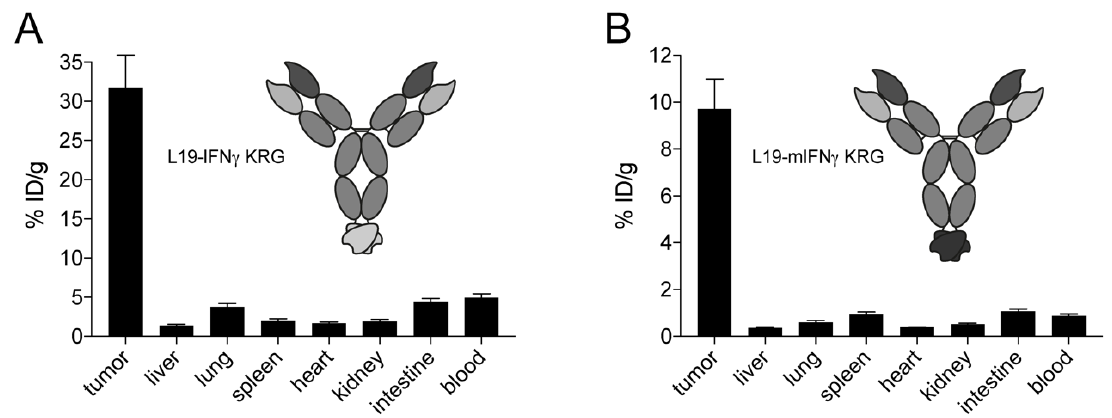
Figure 4. Tumor homing properties of L19-IFN γ KRG and L19-mIFN γ KRG. Quantitative biodistri- bution analysis of radioiodinated L19-IFN γ KRG ( A ) and L19-mIFN γ -KRG ( B ) in immunocompetent mice bearing F9 teratocarcinoma tumors. 10 µ g of radio-labelled fusion protein was injected into the lateral tail vein and mice were sacrificed 48 h after injection, organs and tumor were excised, weighed and the radioactivity of each sample was measured. Results are corrected on tumor growth and expressed as percentage of injected dose per gram of tissue (%ID/g ± SEM), (n = 4 mice per